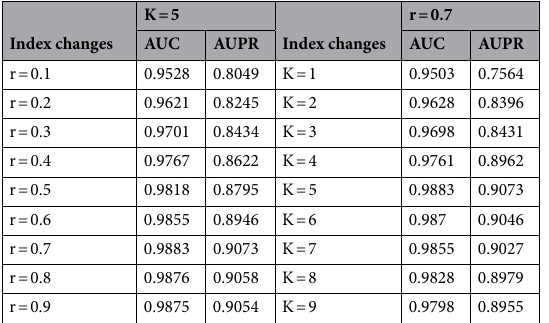
Table 2. Evaluation of index changes in WKNKN